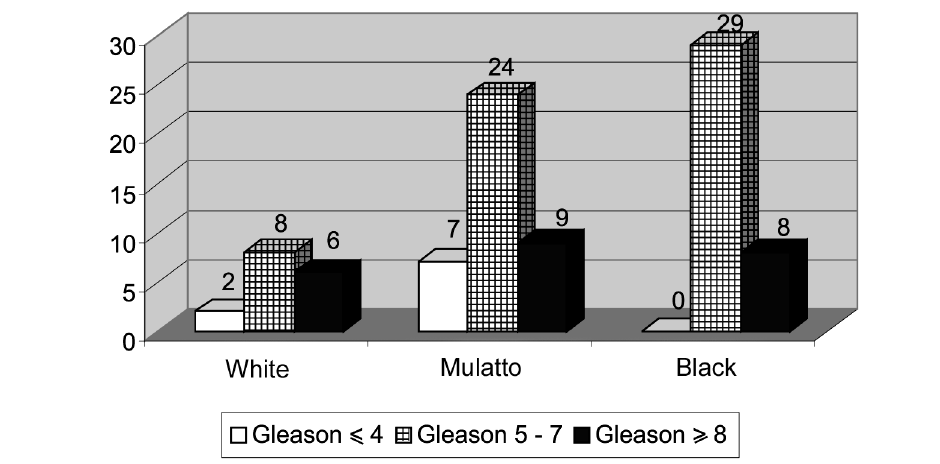
Figure 1 – Gleason score in 93 patients with prostate